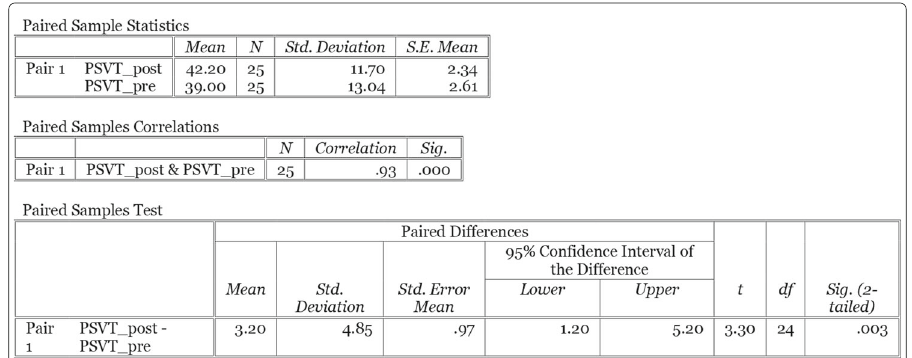
Fig. 21 Paired t-Test (2-tailed) for groups not related to Computer Graphics